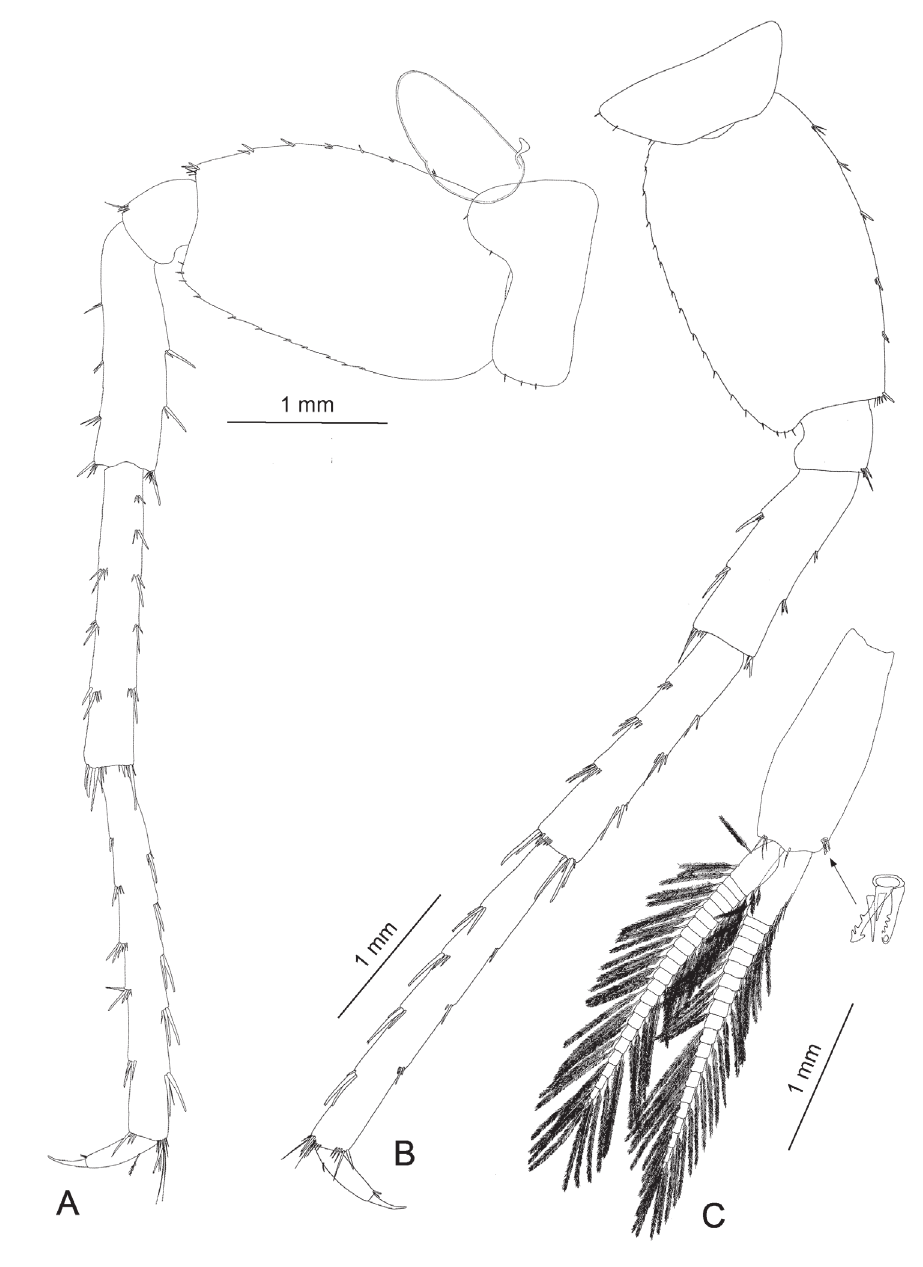
Figure 11. Niphargus enslini , male from the Blätterteighöhle A pereopod VI B Pereopod VII C pleopod I (enlarged: